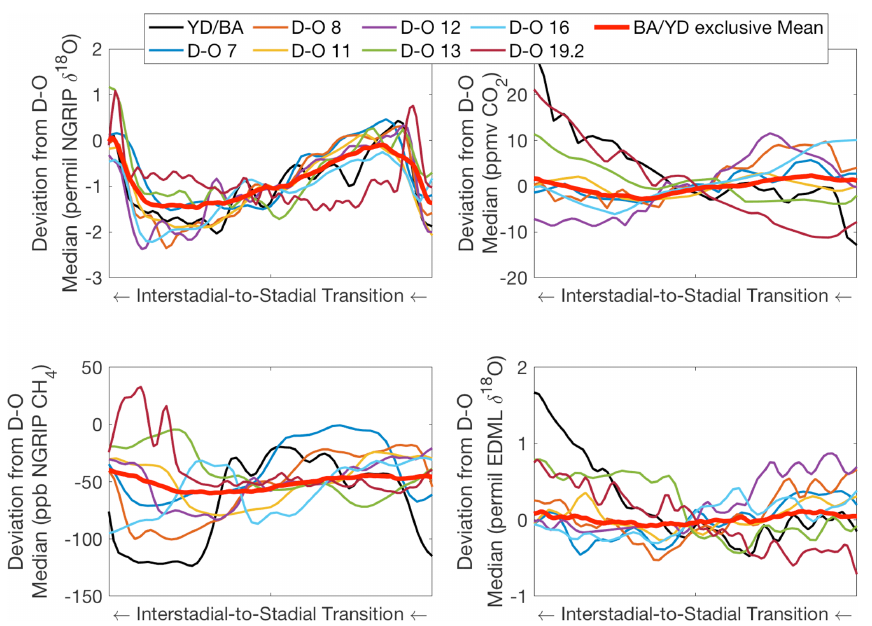
Figure 5. Shapes of eight D–O events and the grand mean (excluding the BA/YD) with respect to all four records. Representing one-third of D–O events during the last glacial period, these D–O events’ respective NGRIP δ 18 O records bear remarkable similarity to that of the BA/YD, despite assumptions of its uniqueness. Additionally, the BA/YD exclusive mean of D–O events’ NGRIP δ 18 O record confirms that the shape of the BA/YD does not visibly deviate from the classic D–O shape. Further, Antarctic records (CO 2 and EDML δ 18 O, second column) show varying trends that do not appear particularly synchronized to the D–O sawtooth shape. NGRIP CH 4 exhibits D–O-like variability, with varying leads and lags. Note: time moves right to left in this